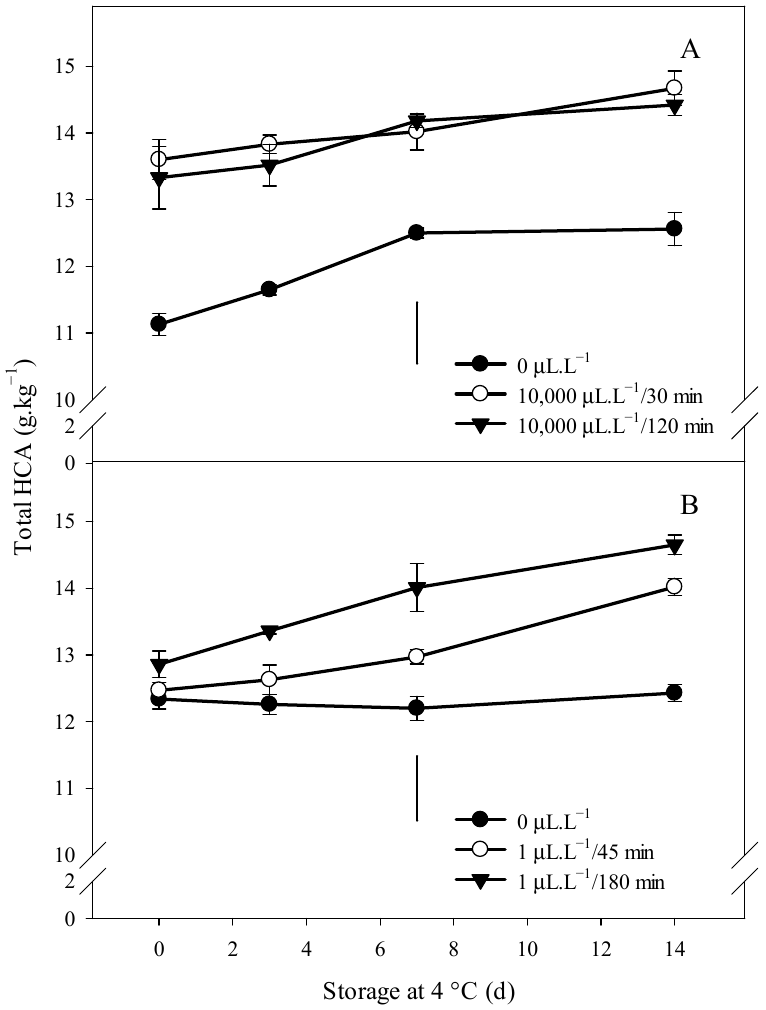
Figure 7. Total hydroxy-cinnamic acid (HCA) content of florets exposed to ethanol and methyl jasmonate. Broccoli florets were treated with ethanol ( A ) at three di ff erent doses: ( ● ), control; ( ○ ), 10,000 µL.L − 1 /30 min (hormetic dose); and ( ▼ ), 10,000 µL.L − 1 /120 min (high dose). Methyl jasmonate ( B ) ( ● ), control; ( ○ ), 1 µL.L − 1 /45 min (hormetic dose); and ( ▼ ), 1 µL.L − 1 /180 min (high dose). Color change ( Δ E) was observed during 21 d of storage in darkness at 4 °C. The content of total HCA (1,2-disinapoyl gentibiose + 1-sinapoyl-2-feruloyl gentibiose + 1,2-diferuloyl gentibiose + 1,2,2-trisinalpoyl-gentibiose + 1,2-disynalpoyl-2-feruloyl gentibiose) was monitored for 14 days of storage in darkness at 4 °C. Vertical bars represent the standard deviation (n = 4). LSD (0.05), EtOH = 0.91; LSD (0.05), MeJA = 0.07. Table 2. Hydroxycinnamic-acid content (HCA) of ethanol and methyl jasmonate-treated broccoli. Florets were exposed to three different doses of ethanol (control: 0 µ L.L − 1 ; hormetic: 10,000 µ L.L − 1 /30 min; high: 10,000 µ L.L − 1 /120 min) and methyl jasmonate (control: 0 µ L.L − 1 ; hormetic: 1 µ L.L − 1 /45 min; high: 1 µ L.L − 1 /180 min), stored for 14 days in darkness at 4 ◦ C, and the obtained values were time averaged (0, 7, and 14 d).